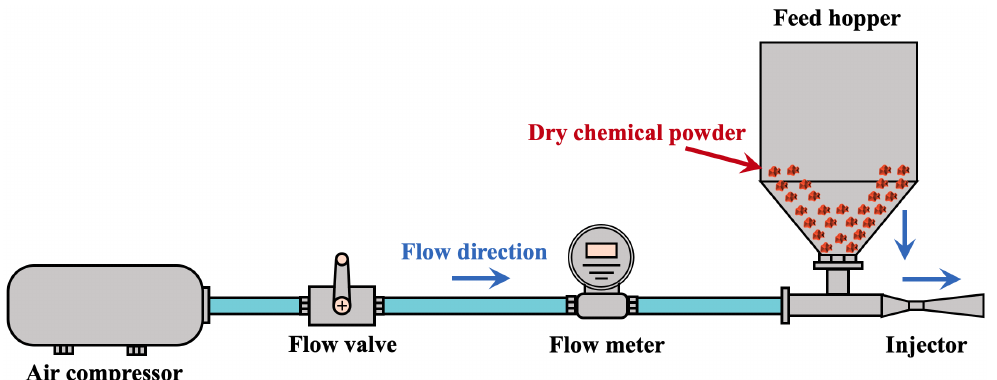
Figure 2. Schematics of the horizontal particle-laden flow